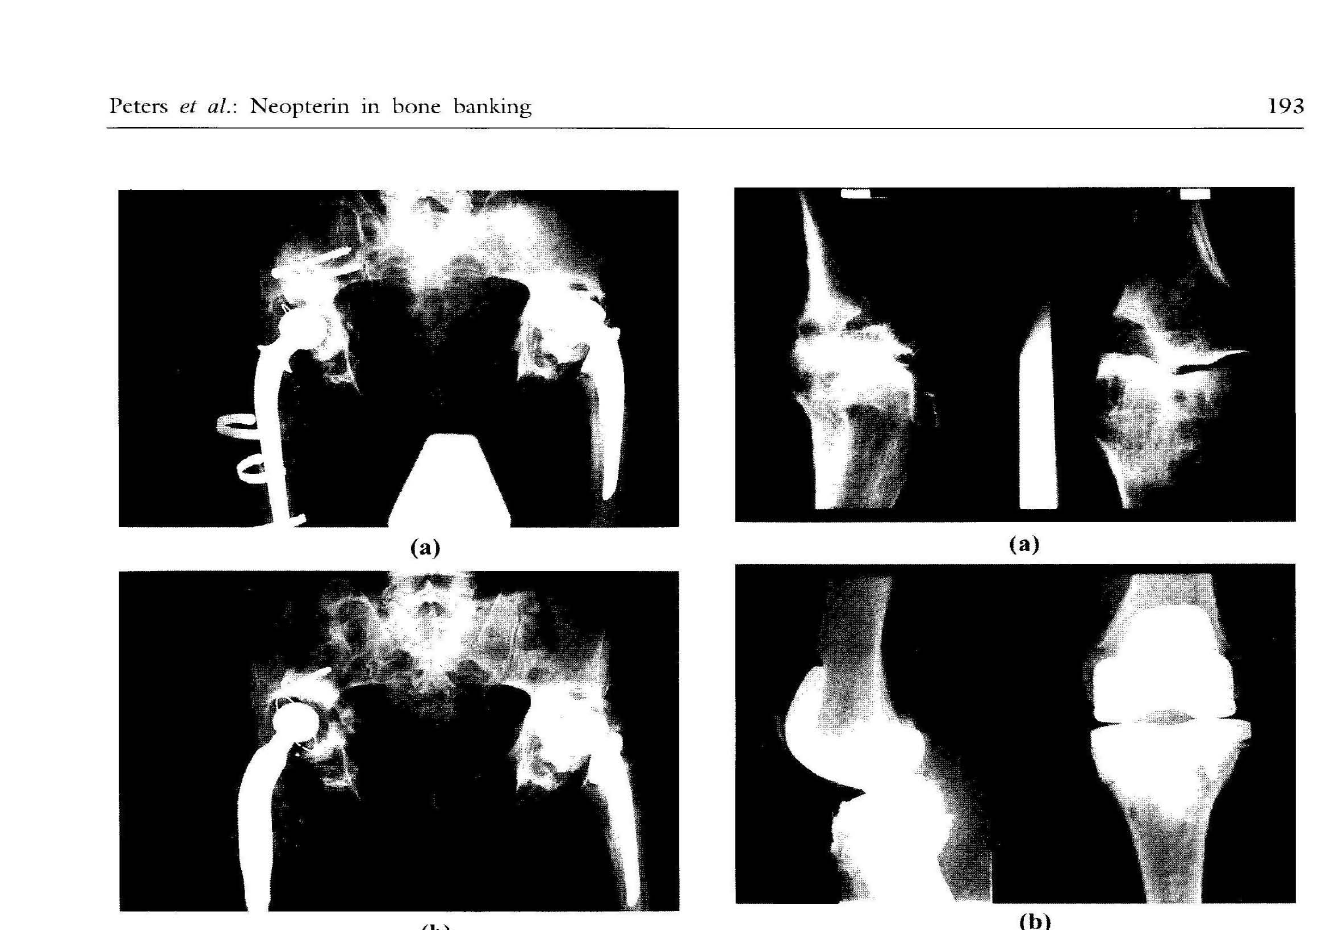
Picture 1. 73-year-old male patient with bilateral total hip replacement: loosening of the endoprostesis of the